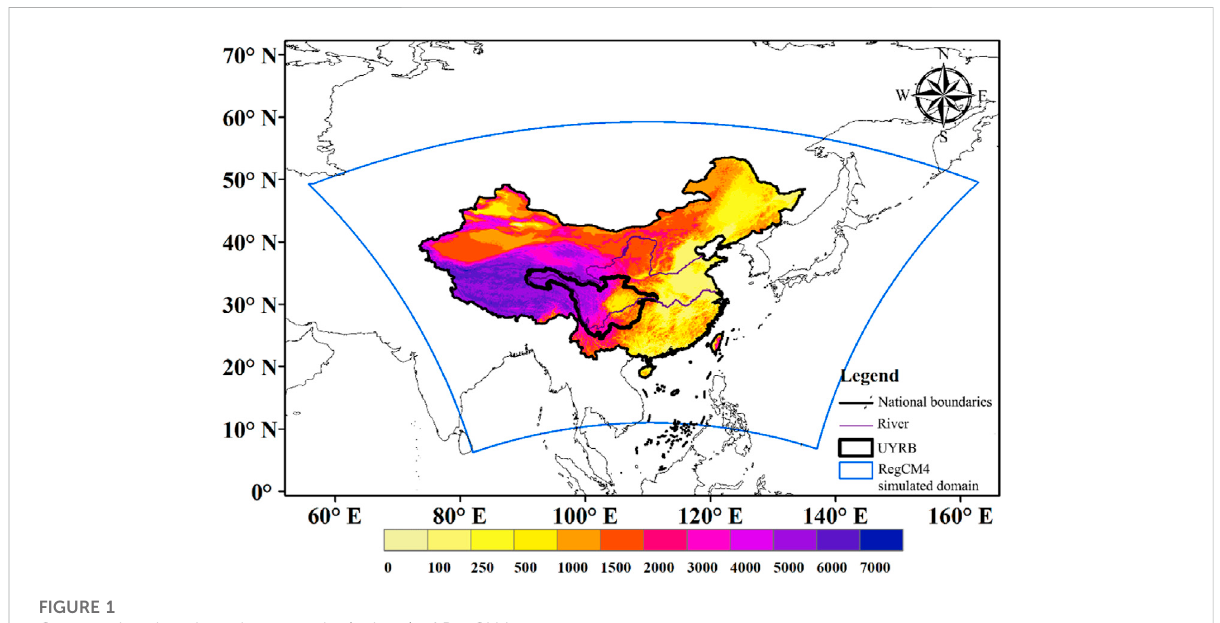
FIGURE 1 Computation domain and topography (unit: m) of RegCM4.